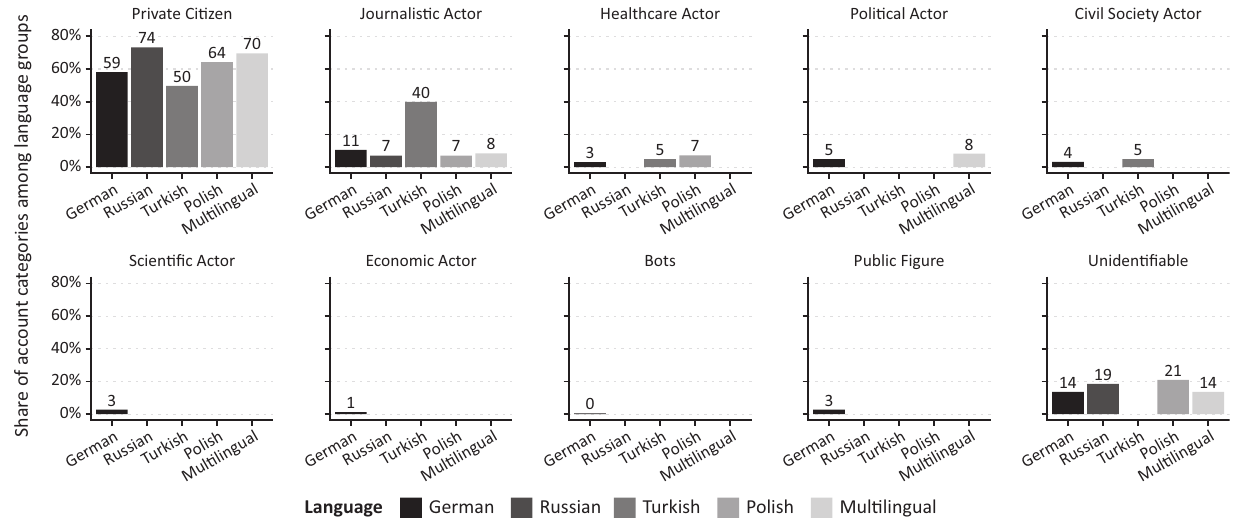
Figure 1. User categories among language groups for accounts with at least two tweets in the sample. Notes: German ( n = 3,103), Russian ( n = 42), Turkish ( n = 20), Polish ( n = 14), Multilingual ( n = 37); no statistically significant association ( p =